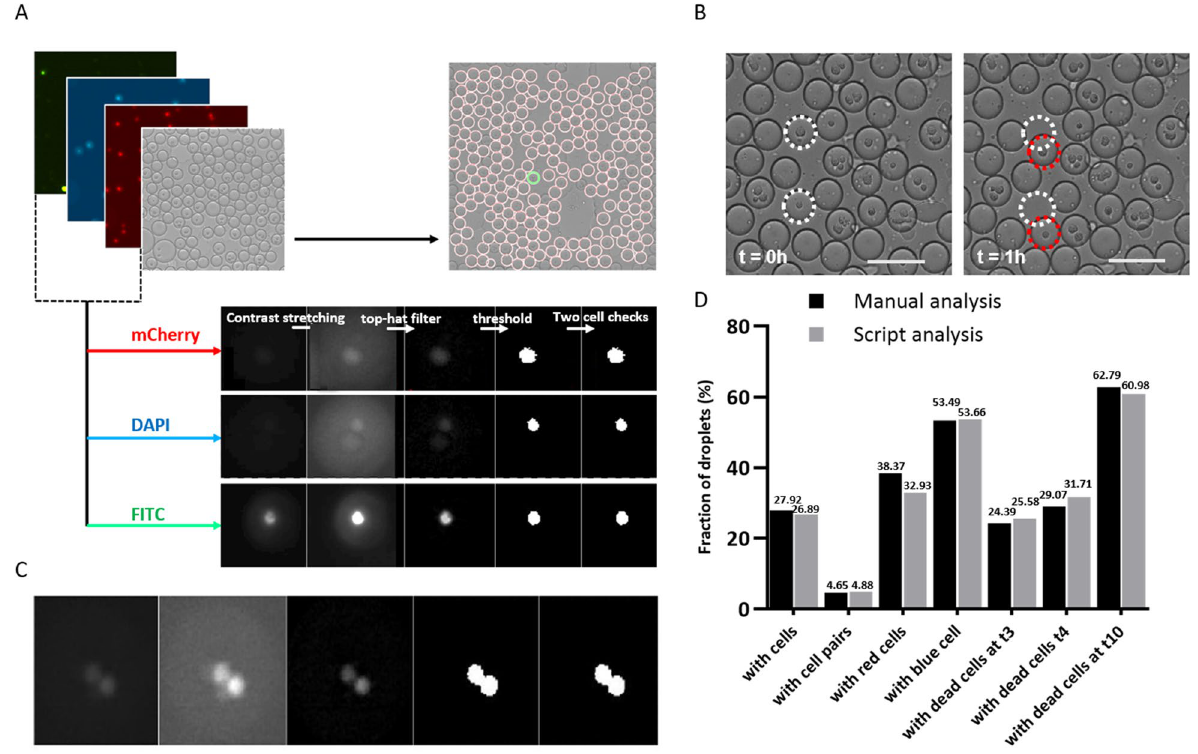
Figure 4. Image processing and analyzing steps in MATLAB script. ( A ) Image processing by stacking different channels, droplet tracing, and detection of cells over each channel. ( B ) Droplet movement over one hour. An adjustable amount of movement is allowed by the script, but if this allowed movement is more than the droplet radius, the risk exists of detecting a different droplet at the next time point. Droplet detection over time is done by comparing the coordinates of the center of the droplet between two consecutive time points and selecting the closest center within the allowed movement range. ( C ) Evaluation of the script for cells recognition over different channels, here two cells labelled with cell tracker blue are identified in DAPI channel). ( D ) Validation of the script by comparing differences in cell distribution, cell pairing, and dead cell identification at three different time points (t = 3 h, t = 4 h, and t = 10 h) in-between script generated data with manually counted